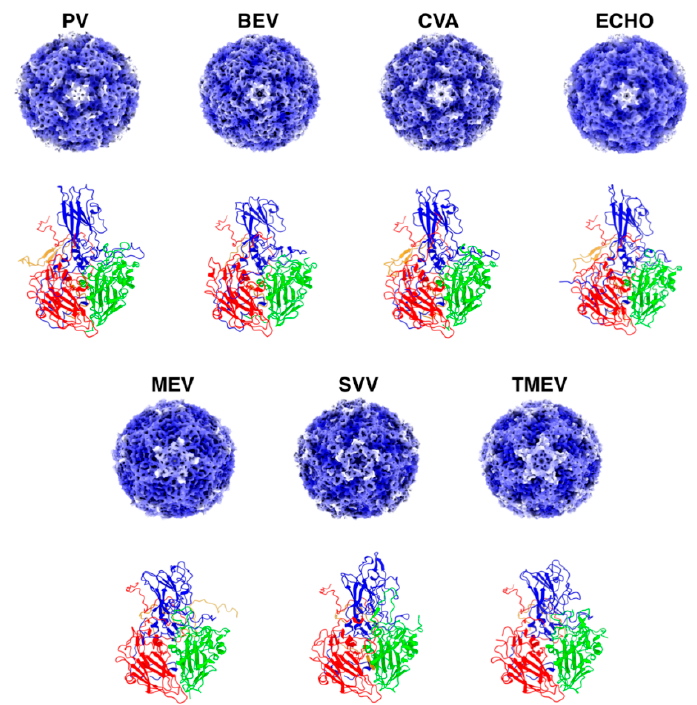
Figure 2. Structures of picornaviruses used in oncovirotherapy. Molecular structures of Type I Poliovirus (PV, PDB ID: 1HXS), Bovine Enterovirus 2 (BEV, PDB ID: 1BEV), Coxsackievirus A21 (CVA, PDB ID: 1Z7S), Echovirus 7 (ECHO, PDB ID: 2X5I), Mengovirus (MEV, PDB ID: 2MEV), Seneca Valley virus (SVV, PDB ID: 3CJI), Theiler’s Murine Encephalomyelitis virus (TMEV, PDB ID: 1TME) and their corresponding protomers. Peaks, intermediate elevations and valleys on depth-cued capsid surfaces are coloured in white, purple and blue, respectively. In capsid protomers, VP1, VP2, VP3 and VP4 are coloured in blue, green, red and yellow, respectively. Figures were generated on ChimeraX [20]. Comparison between the structures can also be seen in the movie: morphs between depth-cued atomic structures of oncolytic picornaviruses (Supplementary Movie).